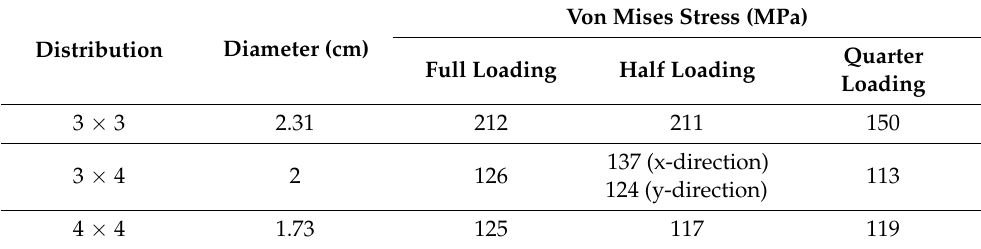
Table 5. Maximum von Mises stress in PEHs. (total cross section area = 37.7 cm 2 ).